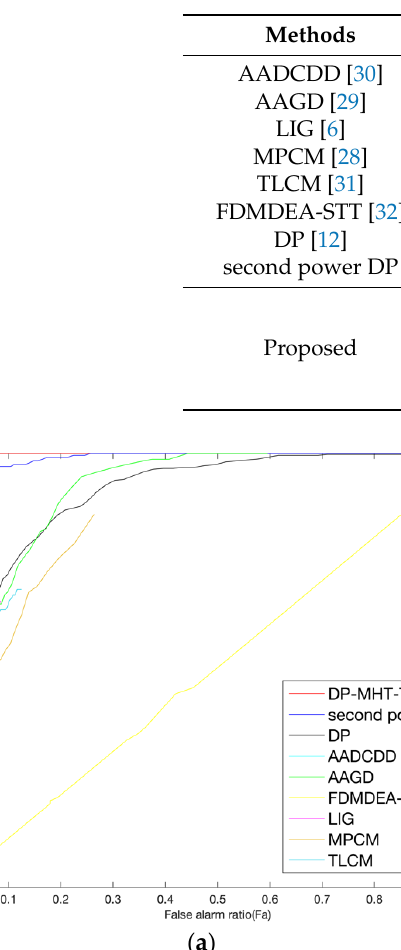
Table 7. Parameter setting and time cost of different methods.